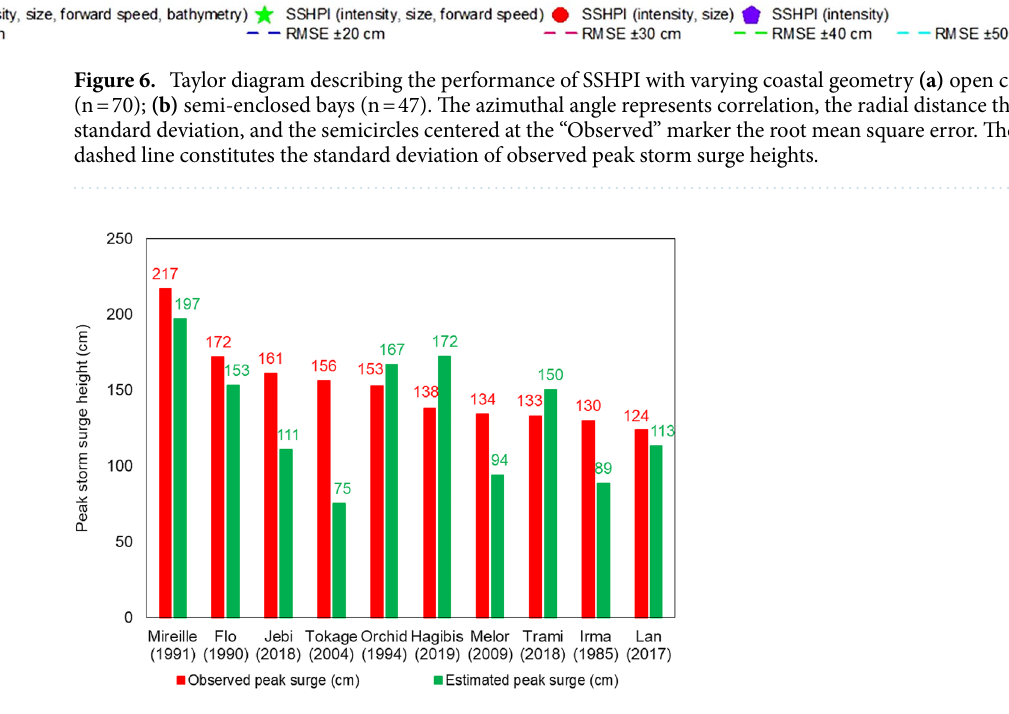
Figure 7. Top ten storm surge events in Japan since 1978 and the estimated peak surge using SSHPI (Eqs. 4 and